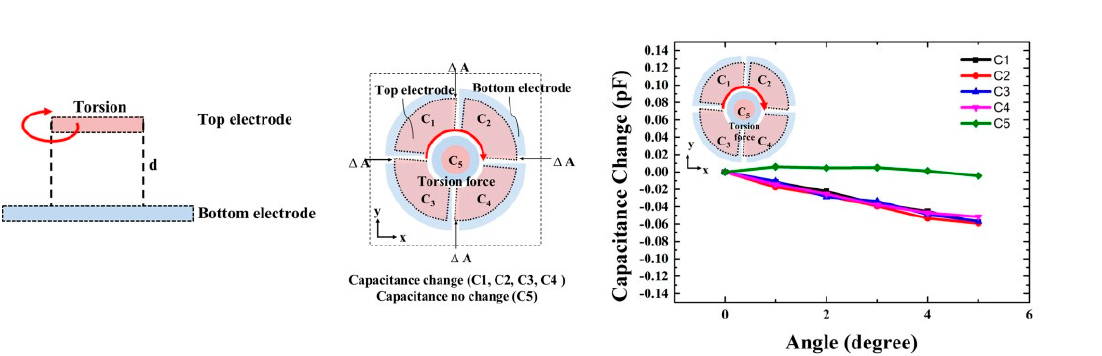
Figure 6. Schematic of ( a ) the sensing mechanism in torsion ( b ) the measured capacitance changes for the torsion in the x-y